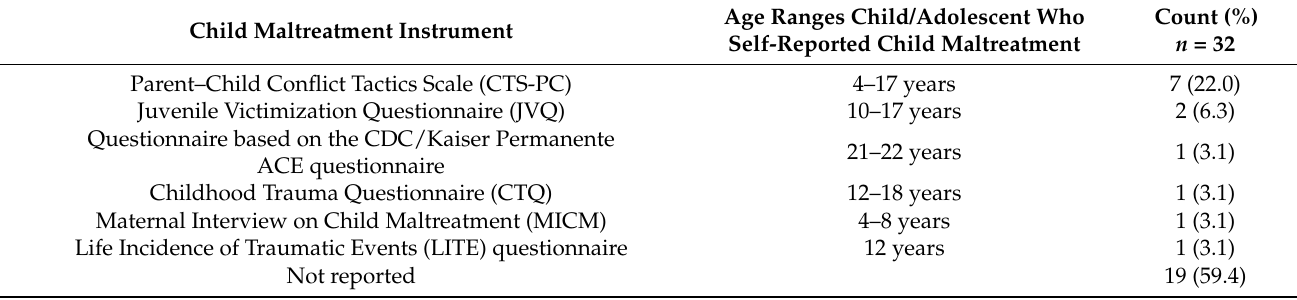
Table 5. Child maltreatment measures and children/youth age ranges. Child Maltreatment